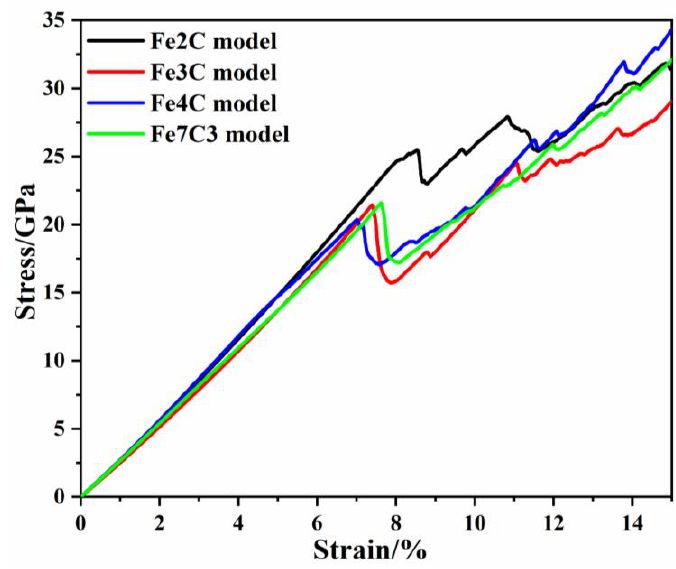
Figure 2. Stress – strain curve of all ferrite – carbide models.